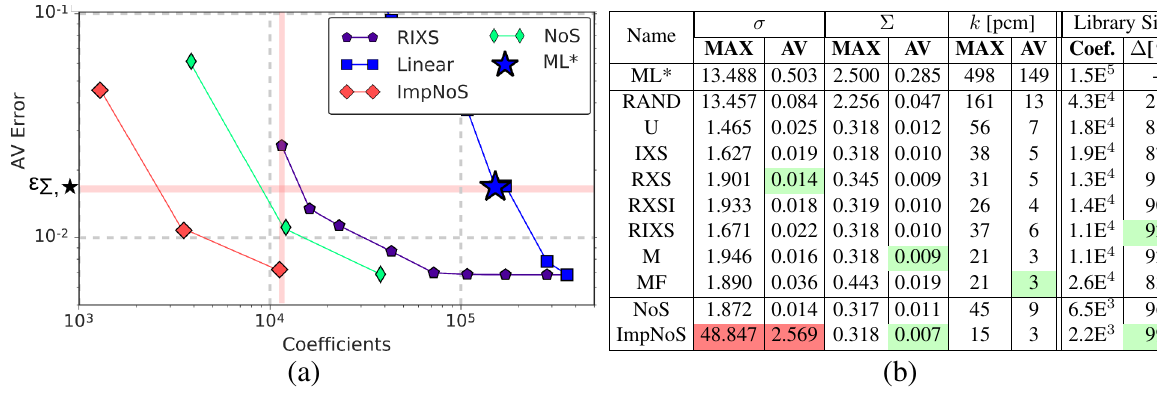
Figure 3: (a) Average Σ error without shared support. (b) Errors for AL models for σ , Σ , k . Errors at constant support ∼ 1 × 10 4 coefficients. Library size at constant error ε ∞